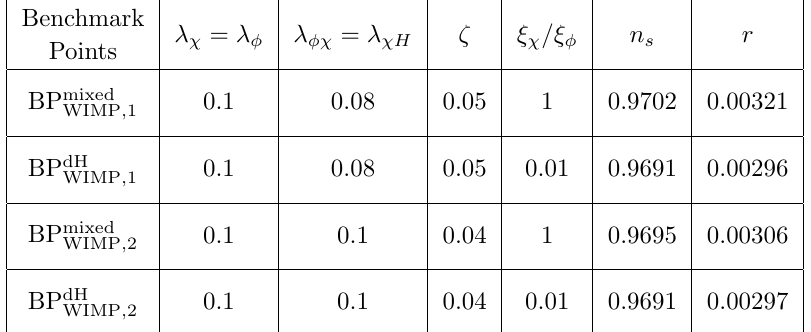
(BP dH ) is the benchmark WIMP ; 1 WIMP ; 1